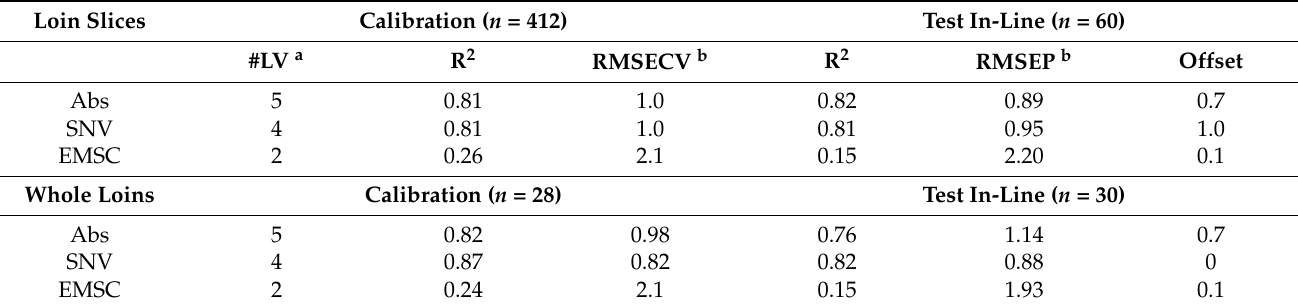
Table 1. Results of calibration and testing in industry.